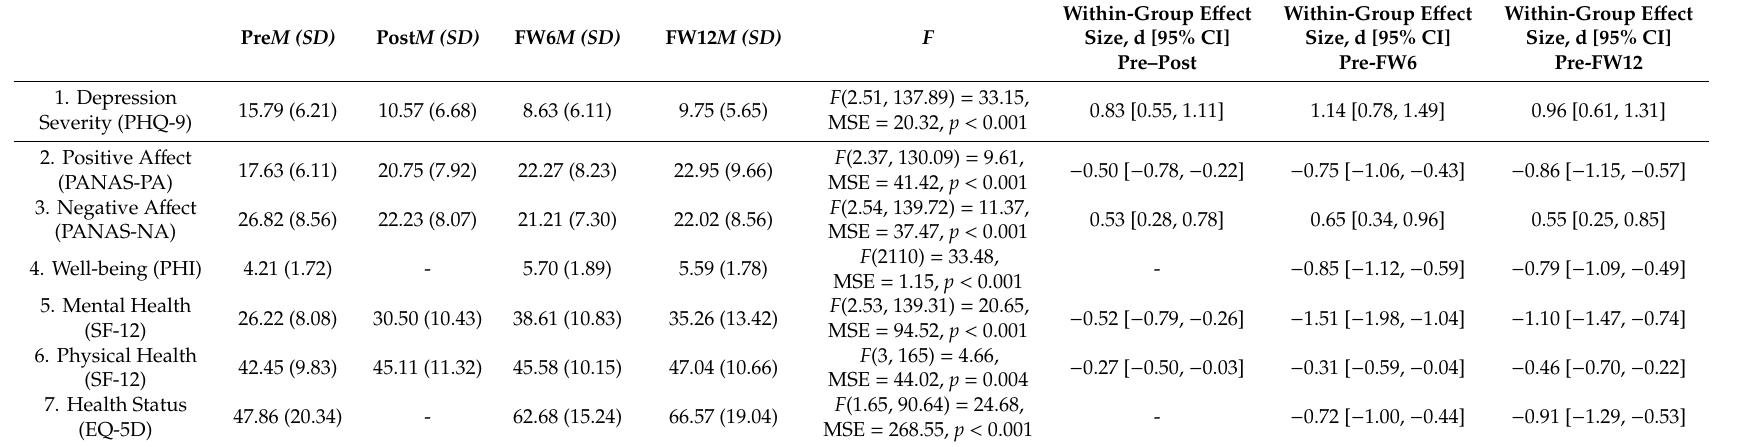
Table 3. Descriptive statistics and repeated-measures ANOVA results of the primary and secondary